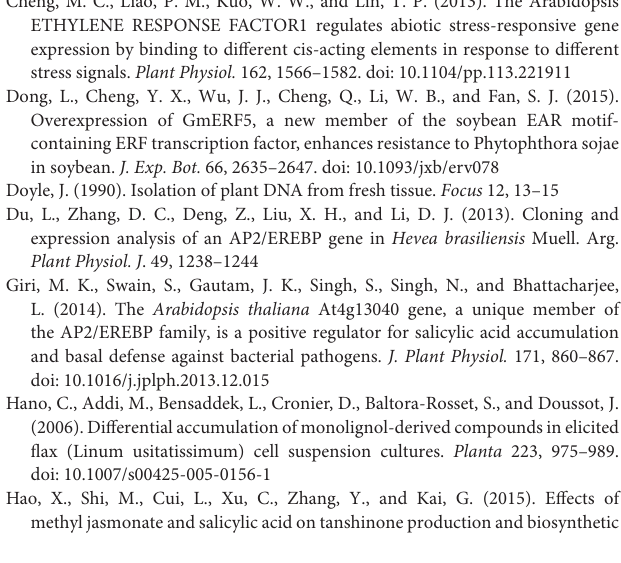
Supplementary Figure S1 | Nucleotide sequence and the deduced amino acid sequence of Ii049 . Supplementary Figure S2 | Sequences of IiPAL promoter. Supplementary Figure S3 | Schematic diagram of constructed plant expression vectors.